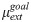
Planning in complex environments.(a) Propagated wave of activity from the goal at (1,1) through a 20 × 20 network with obstacles (black bars) is demonstrated in space-space color coded plot of firing times relative to the goal neuron. The intrinsic frequency of the goal neuron is 18 Hz. (b, c) Two examples of navigation path (blue lines) in the network from different start positions (•) to the same goal (◂) such that a slight shift of the starting position implies an entirely different shortest path. The input to the planning layer is μextgoal = 12.5 and μ
ext = 12 and the noise level is σ
ext = 0.7. The planning time takes 1 s and readout time is 150 ms.